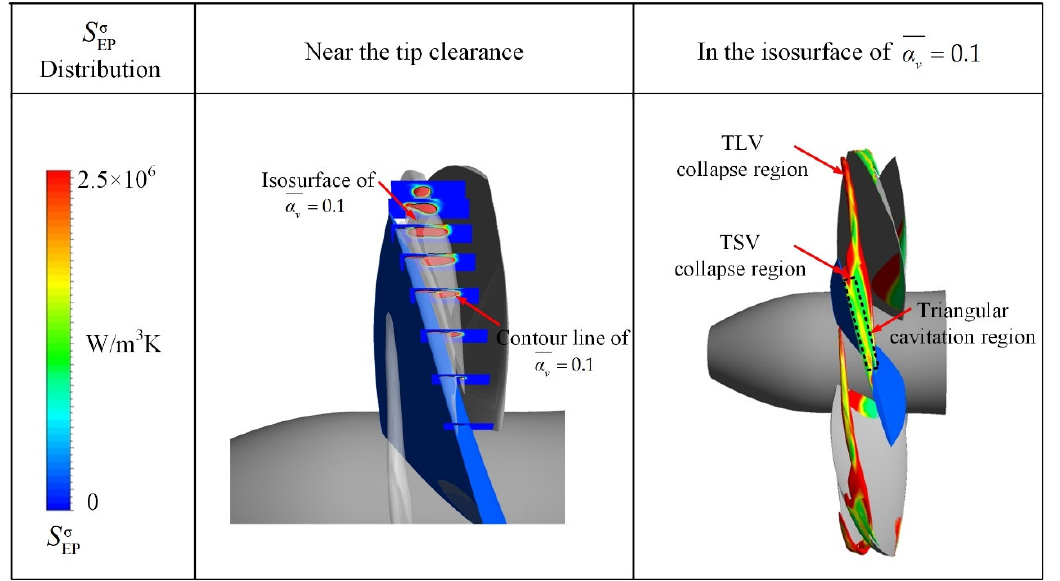
Figure 13. Interface entropy-production-rate distributions near the tip clearance and in the isosur- face of α v  = 0.1. of α v =